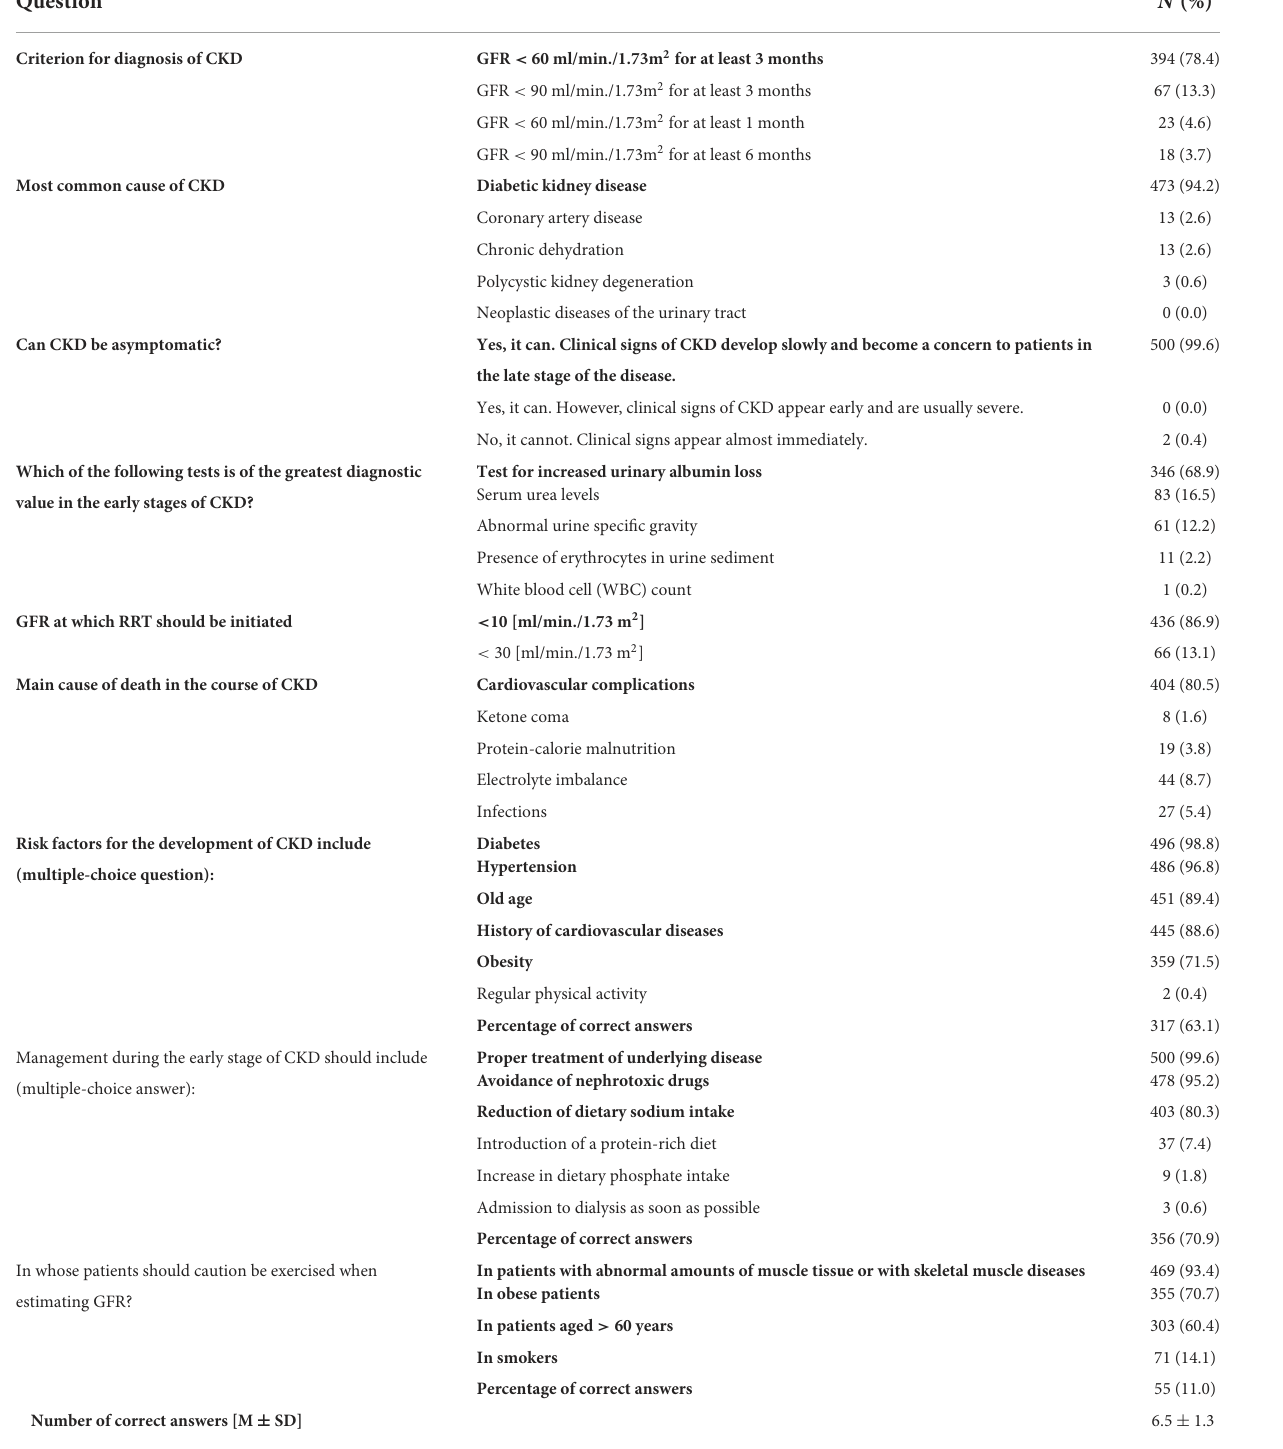
TABLE 2 The comparison of answers to questions assessing the level of knowledge of CKD.